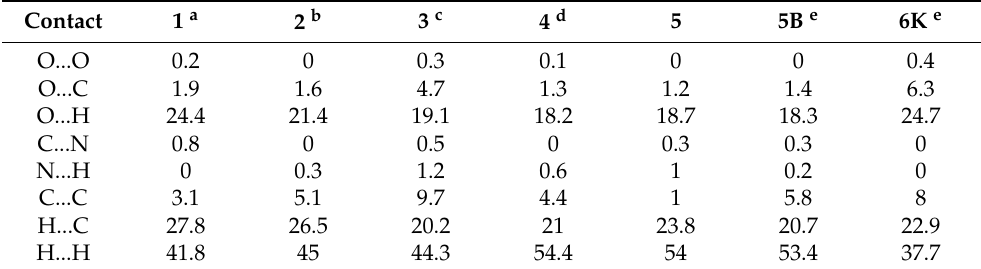
Table 3. The contact percentages in the crystal structure of the studied compounds.